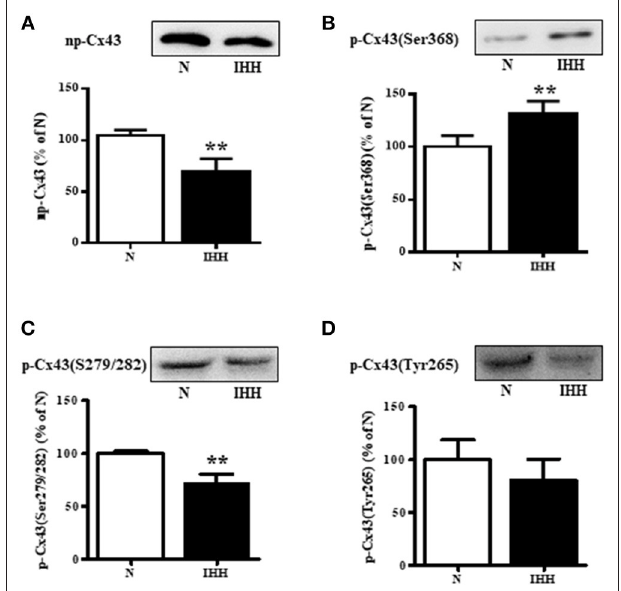
FIGURE 2 | Effect of chronic intermittent hypobaric hypoxia (IHH, black columns) on protein level of non-phosphorylated Cx43 (A) , phosphorylated Cx43 at Ser368 (B) , phosphorylated Cx43 at Ser279/282 (C) , and phosphorylated Cx43 at Tyr265 (D) assessed by western blotting in the left ventricular myocardium. N, normoxic group (open columns). Values are mean ± SEM, ( n = 5 in each group), ** P < 0.01.